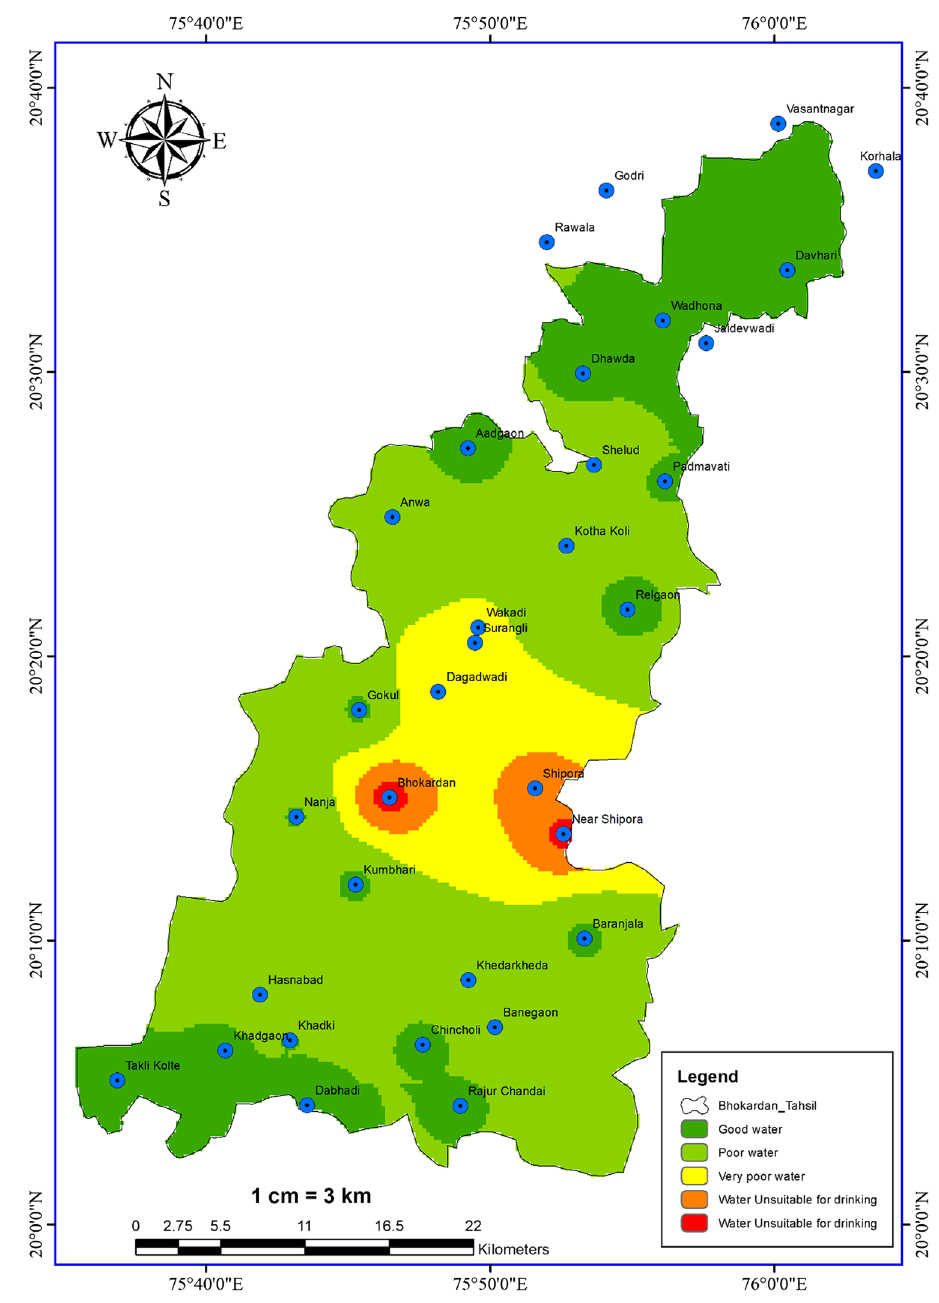
Fig. 5 Showing spatial distribu- tion of GWQI during post- monsoon